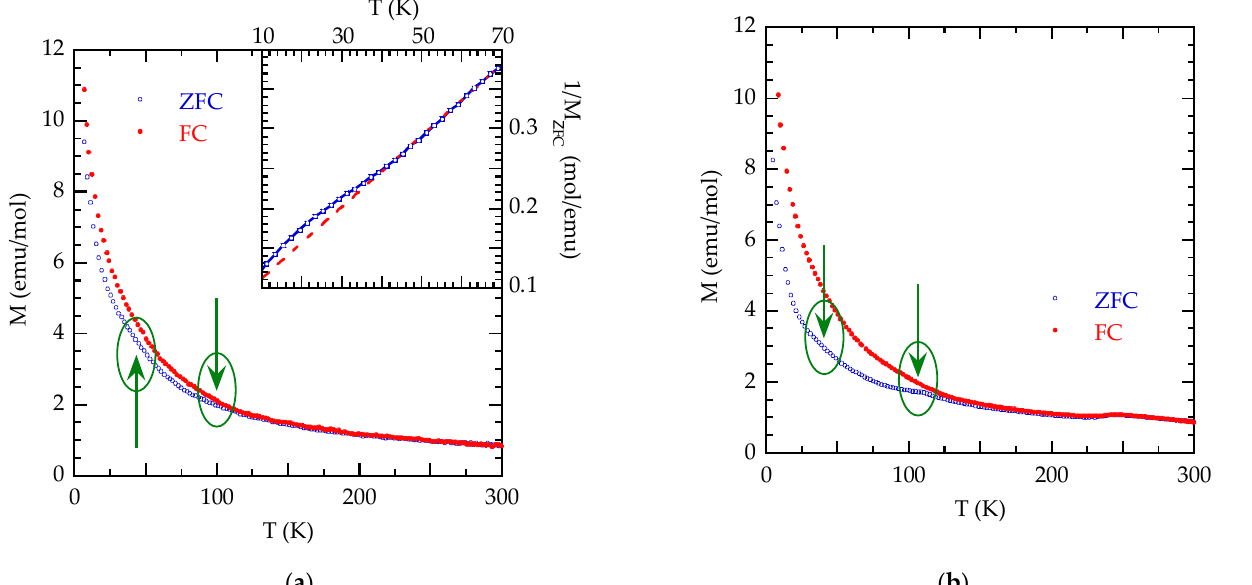
Figure 6. ( a ) Zero-field-cooled (ZFC, blue empty dots), field-cooled (FC, red full dots) magnetization curves of the nanometric sample recorded at H = 25 Oe. Green arrows and ellipses are guides for the eye for the identification of the transitions. Inset displays the inverse ZFC branch. The straight red line is a guide for the eye to evidence the deviation from the linear behavior on cooling. ( b ) Corresponding ZFC-FC magnetization curves for the micrometric sample.